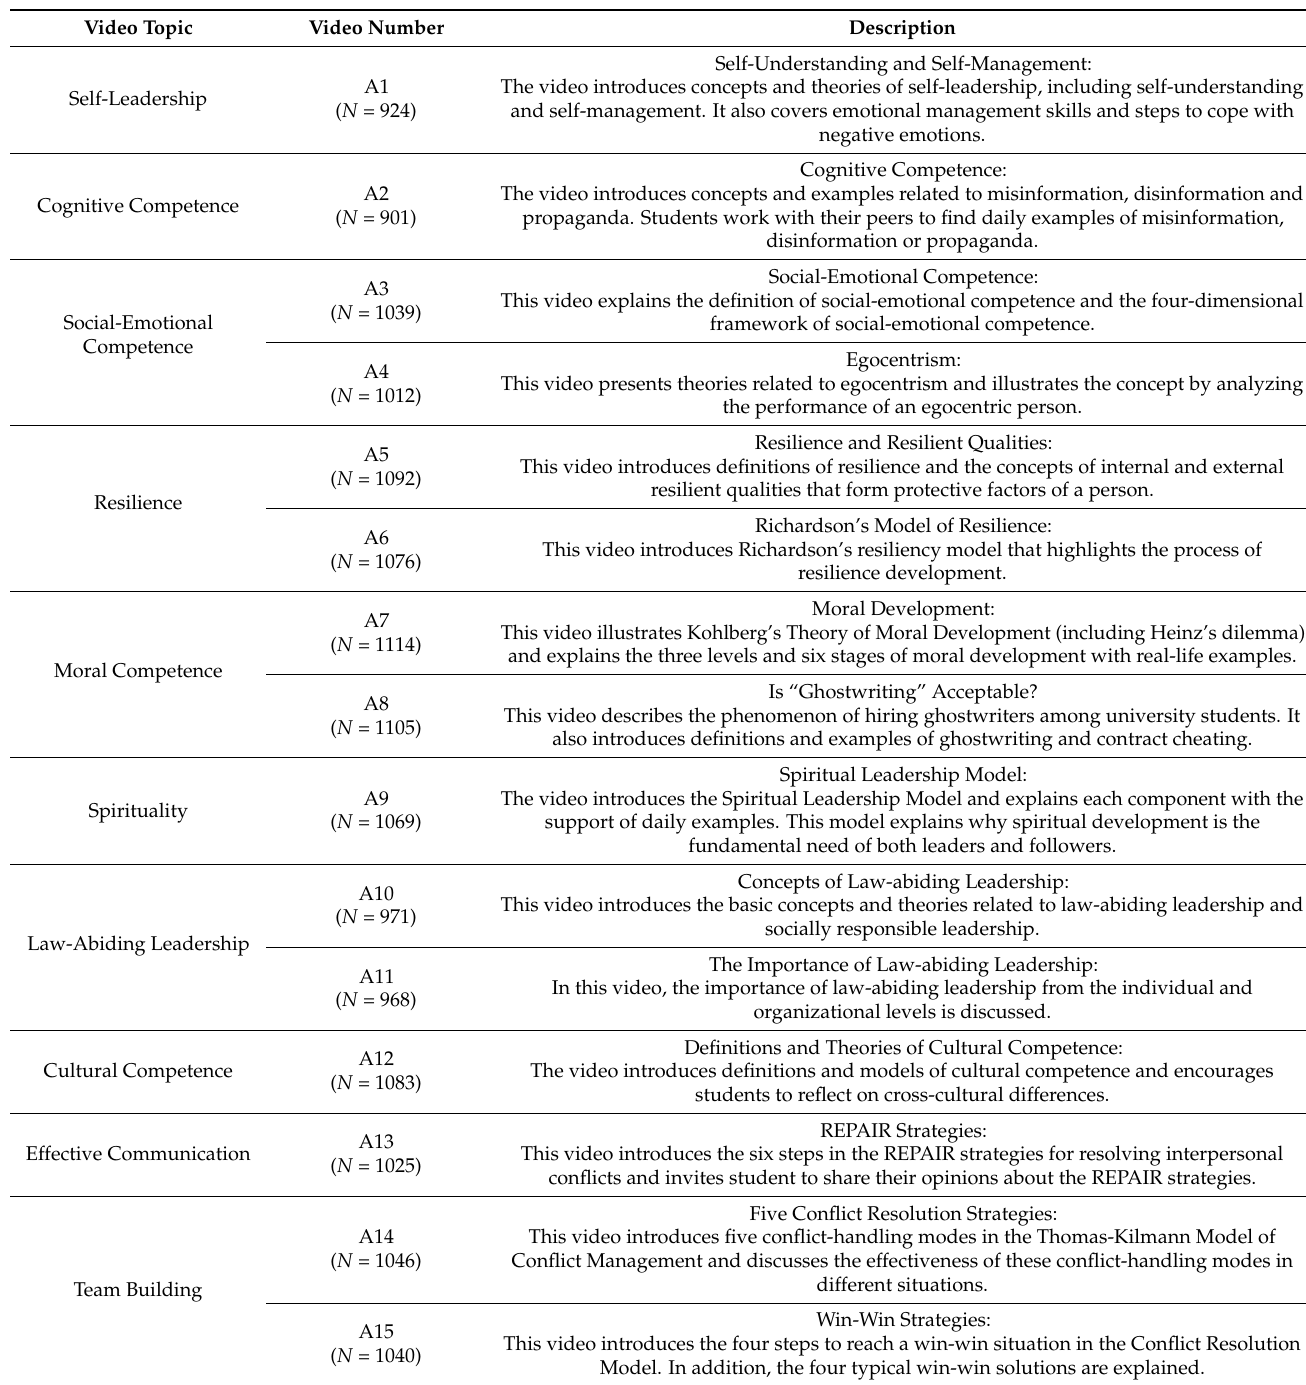
Table 1. Description of the 15 Animated